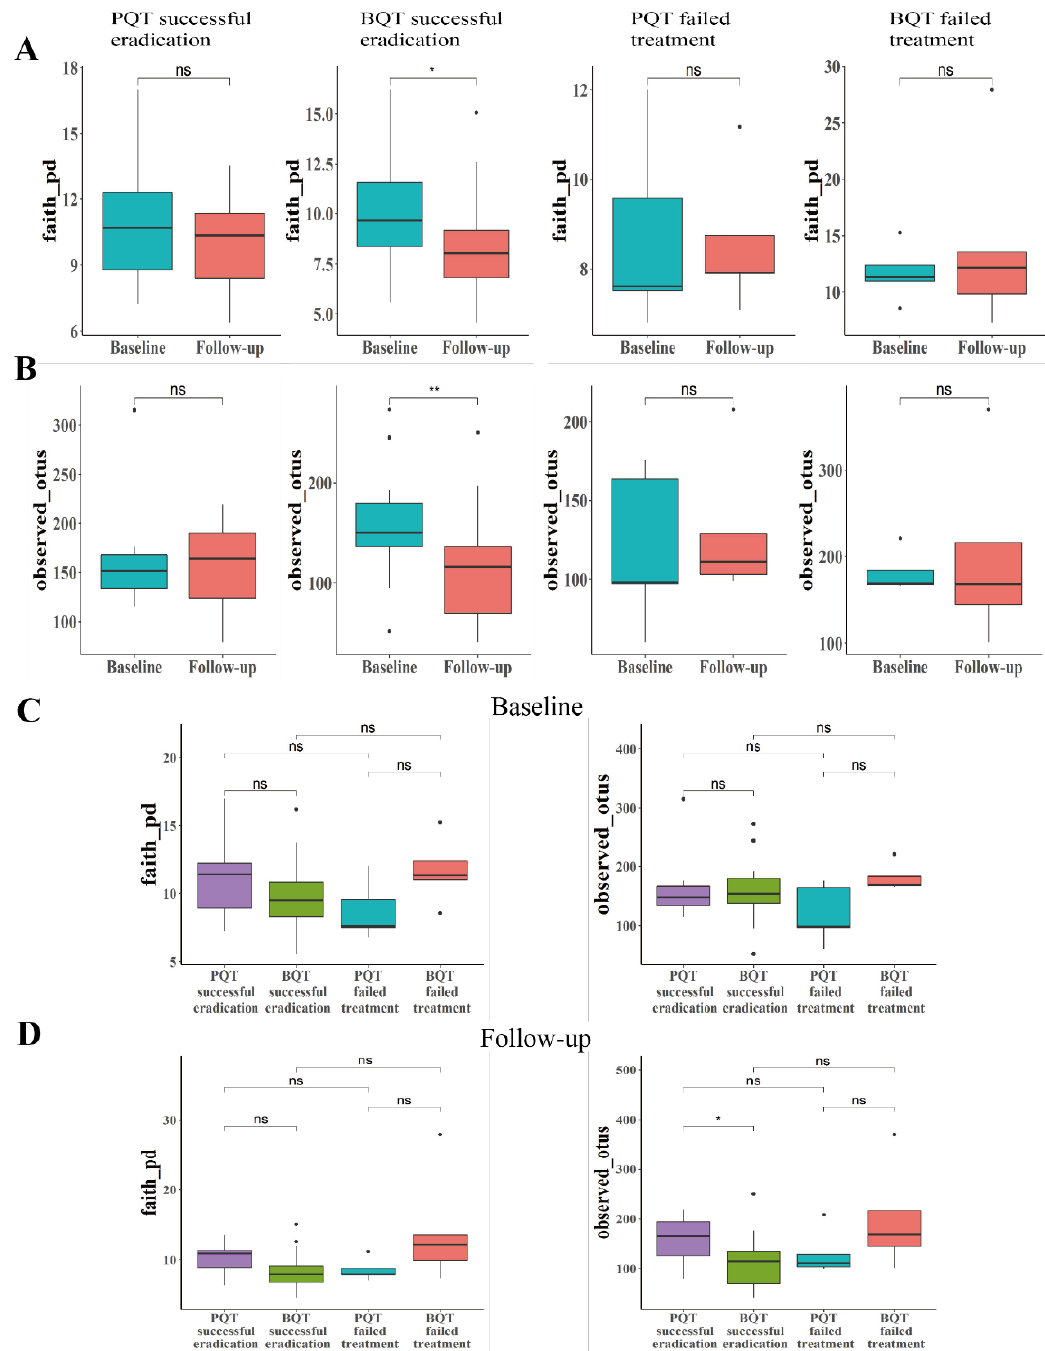
Figure 2. The comparisons of alpha diversities among the four groups. Faith pd ( A ) and observed otus ( B ) indices represent the alpha diversity changes from baseline to the end of treatment. The comparison of intergroup alpha diversities differences at baseline ( C ) and follow-up ( D ). *, p -values < 0.05. ** p -values <